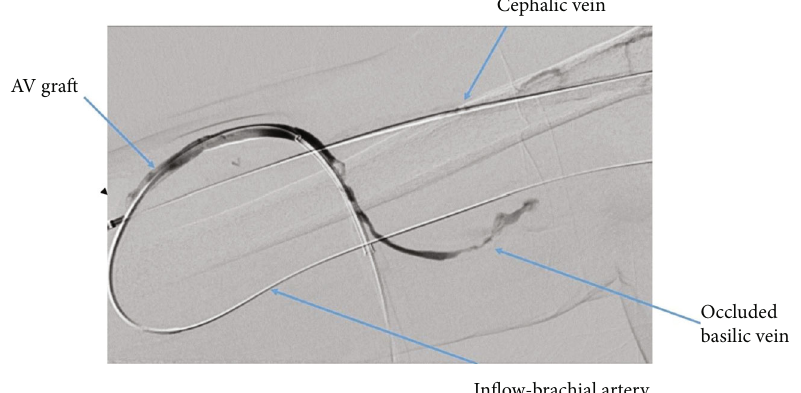
Figure 1: Thrombosed basilic vein.